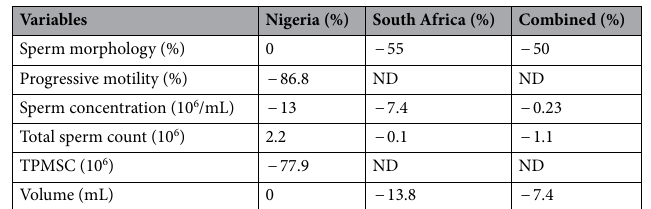
Table 3. Summary of percentage increase/decrease of data between 2010 and 2019. Percentage change was calculated using the median values. ND No data due to small sample size.